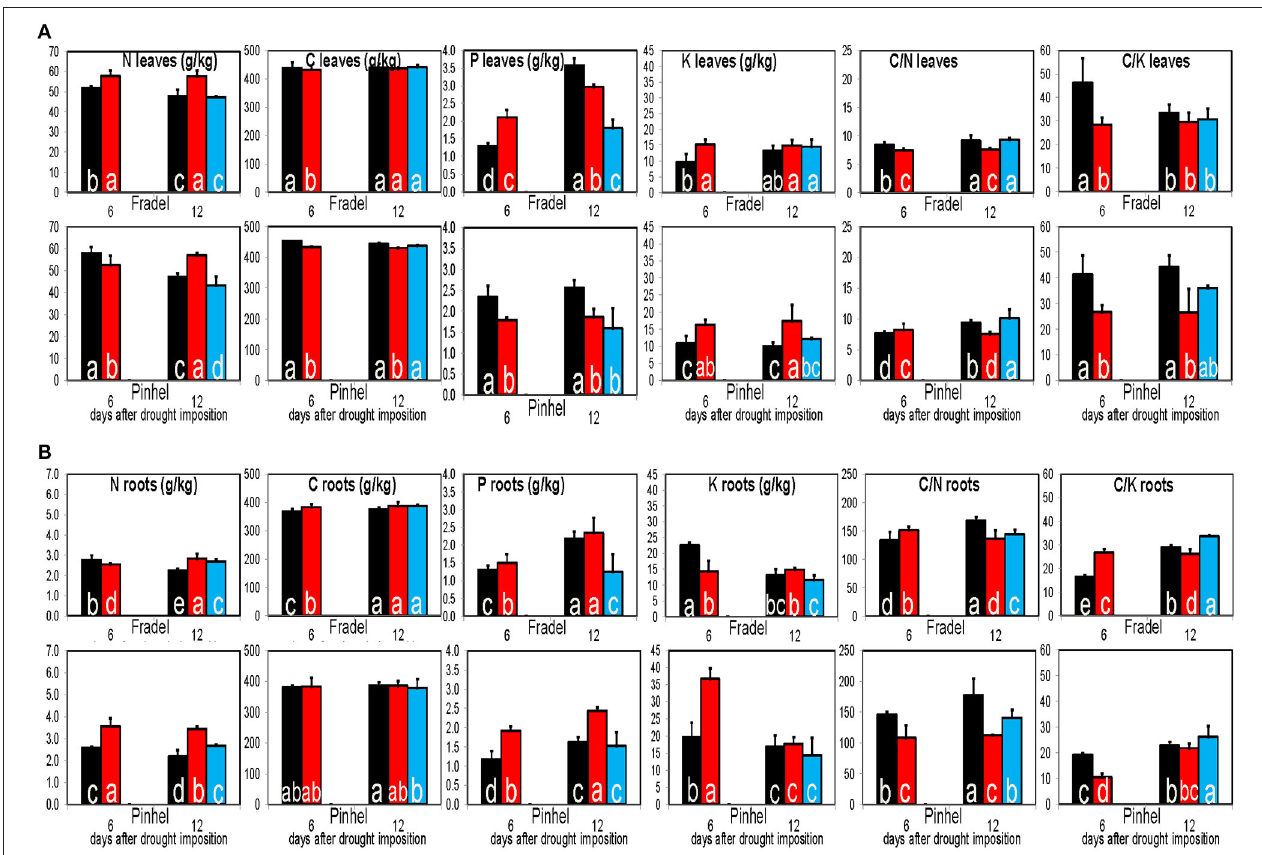
FIGURE 15 | Elemental solute levels in leaves (A) and roots (B) of cowpea in response to drought stress and rewatering. Bars indicate the well-watered controls (black), plants drought-stressed for 6 or 12 days (red), and rewatered plants after 6 days of drought stress (blue; n = 3–6; error bars = SD). Different letters inside the columns for each cultivar denote statistical differences (Tukey’s test; P <